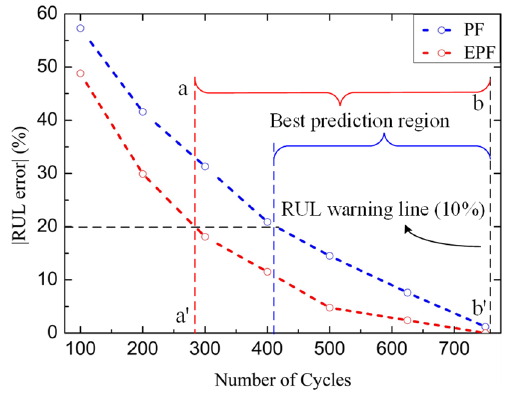
Figure 14. Comparison of RUL prediction errors between the EPF and PF.